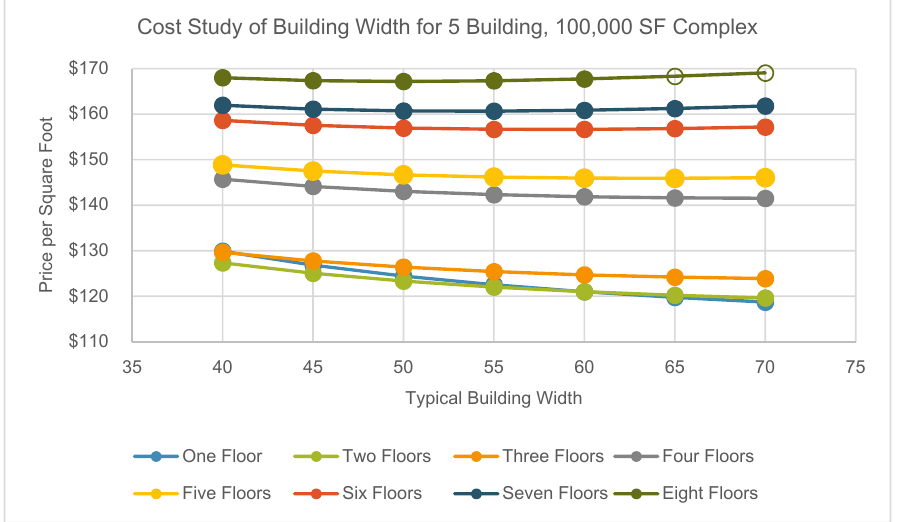
Figure 3. Cost Study of Building Widths with a Constant Total Project Volume and Number of Buildings and Variable Floor Heights.